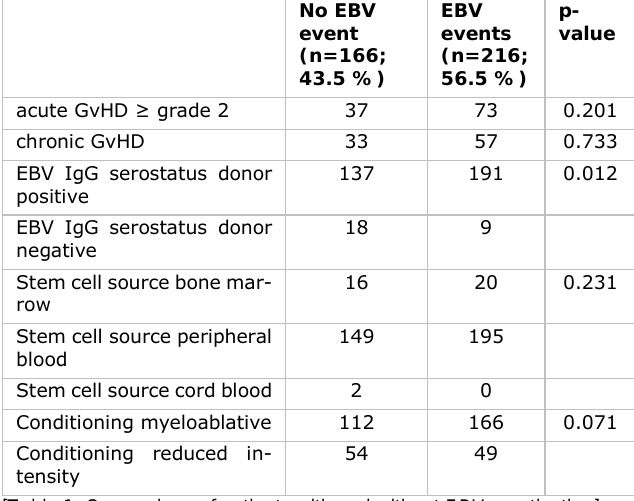
[Table 1. Comparison of patients with and without EBV